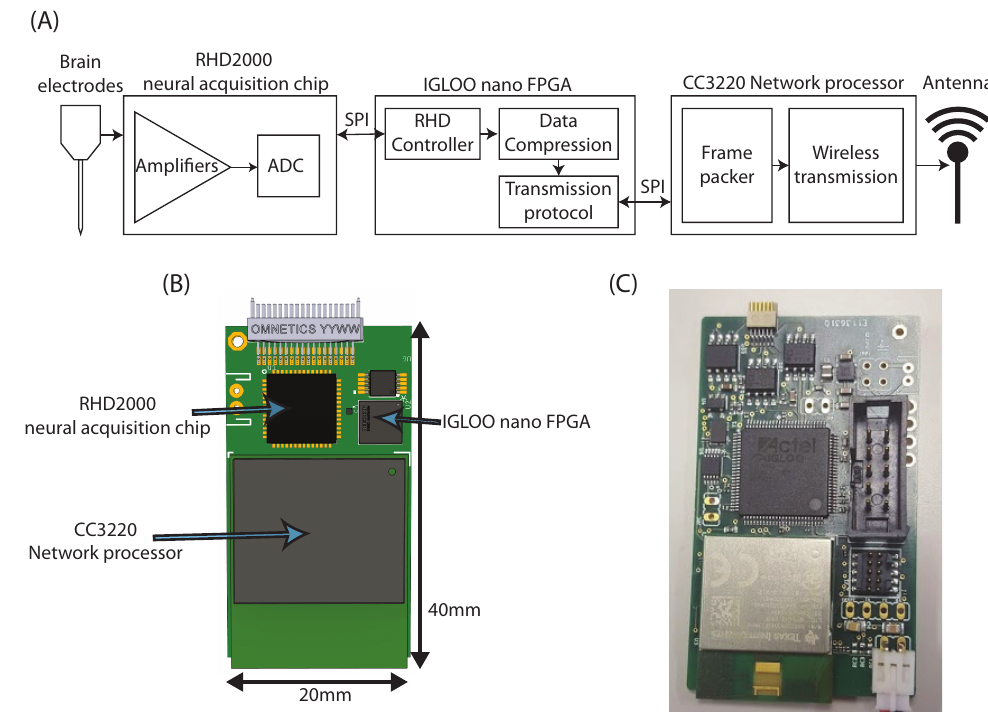
Figure 3. ( A ) Functional diagram of the developed prototype. ( B ) Sketch of a complete device. ( C ) Picture of the built prototype. For development purposes, the layout differs from what would be a finished unit, including the addition of debugging headers and the use of bigger versions of the integrated